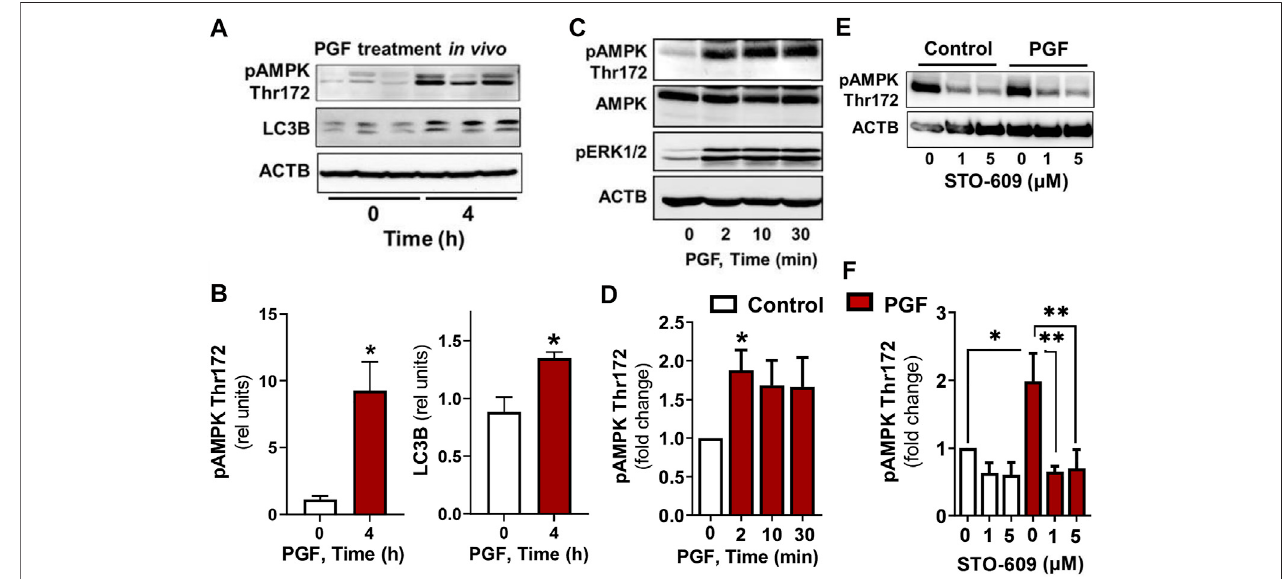
FIGURE 1 | AMPK activity and markers of autophagy increase in the bovine corpus luteum during luteal regression. Representative blots (A) and bar graphs (B) showing phosphorylation of AMPK α (Thr172) and content of LC3B in luteal tissue post-PGF2 α injection in vivo . (C – F) Primary cultures of bovine small luteal cells were treatedwithPGF2 α orpretreatedwithinhibitorofCAMKK2(STO-609)andthentreatedwithPGF2 α (100 nM).Representativeblots (C,E) andbargraphs (D,F) showing phosphorylationofAMPK α (Thr172),ERK1/2,andtotalAMPK α inthelutealcells.Dataareshown asarelativeunitsorfoldchangeandpresented asmeans ± SEM from three-four separate experiments. Data were normalized to β -actin (ACTB). Statistical analysis was performed using student ’ s t-test or one-way ANOVA test with post hoc Bonferroni test. *, ** as p < 0.05 and p < 0.01.